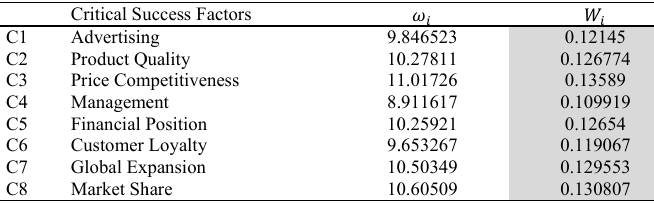
of Critical S Success Fac